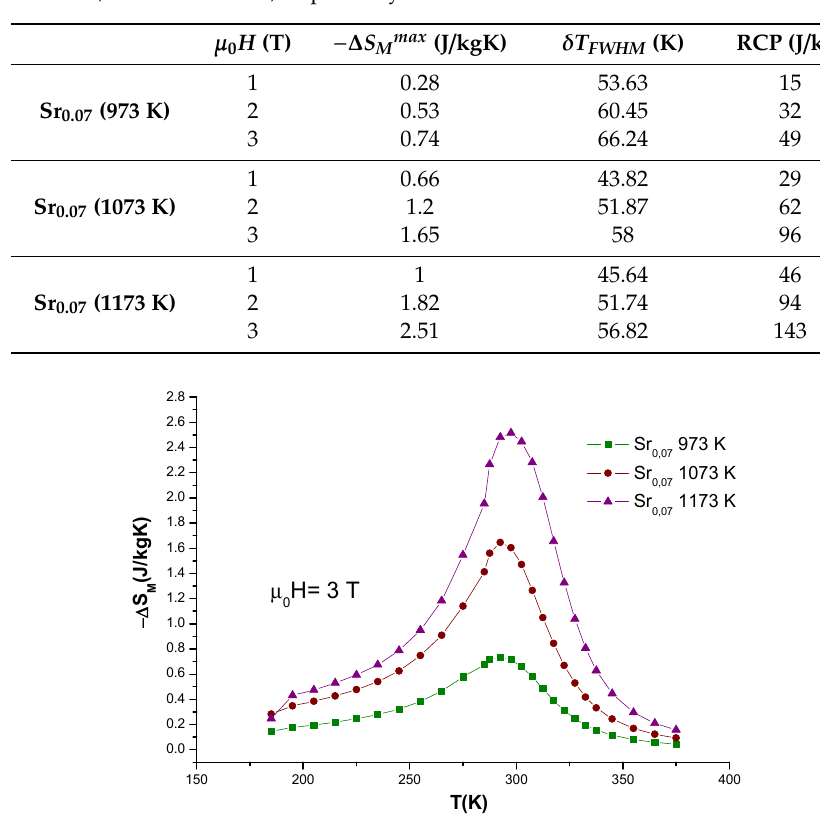
Figure 5. Magnetic entropy change for applied magnetic field of µ 0 H = 3 T for La 0.7 Ca 0.23 Sr 0.07 MnO 3 nanofibers. It is possible to observe relative cooling power (RCP) increment by the broad shape on all curves.